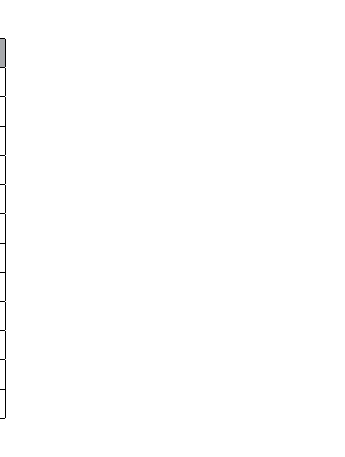
Table 7. Results of classifiers trained on reduced train